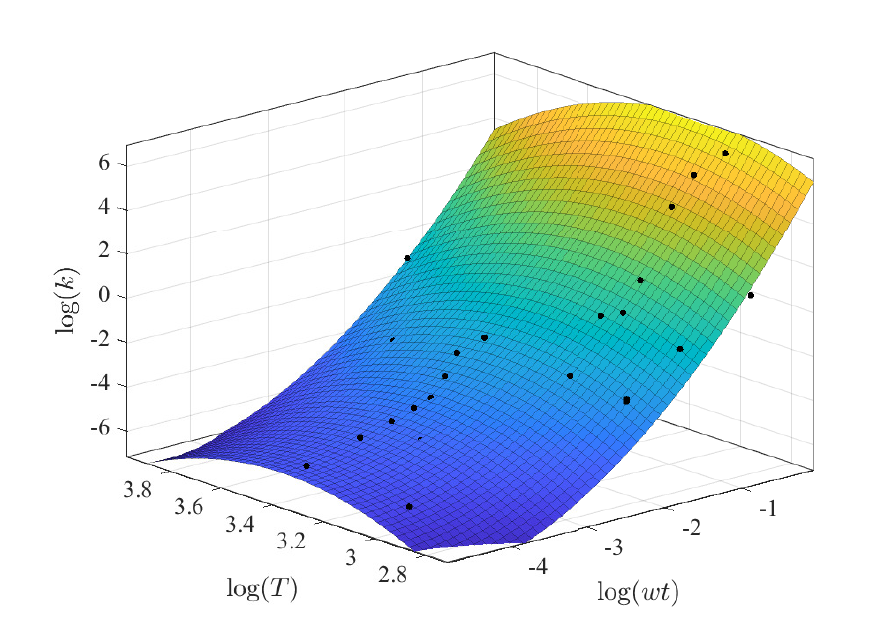
Figure 10. Best fitting results for the XG dataset with log ( k ) as a function of log ( wt ) and log ( T ) .